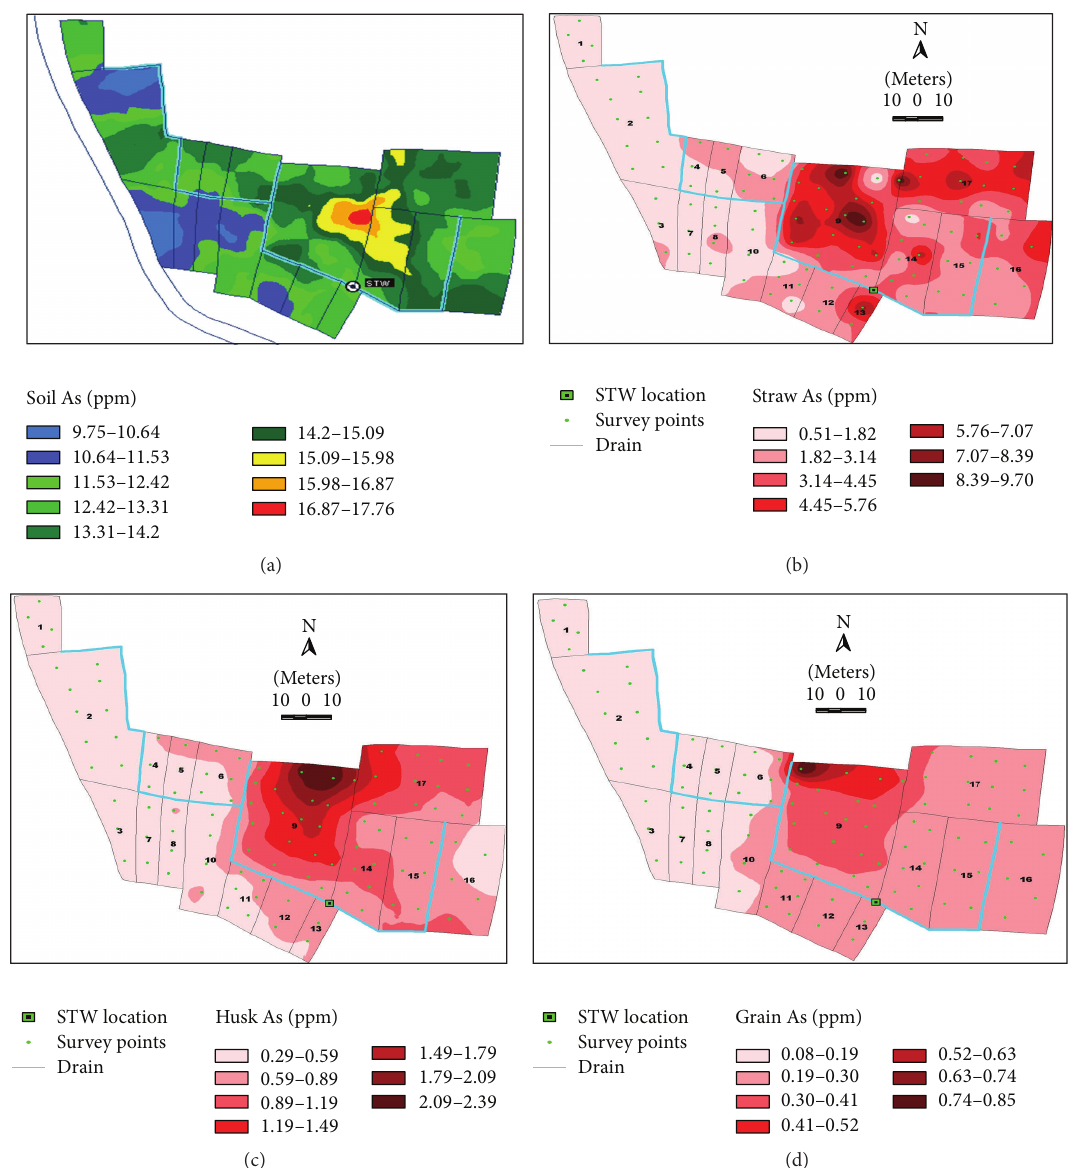
Figure 8: (a) Map of spatial variation of soil As. (b) Map of spatial variation of straw As. (c) Map of spatial variation of husk As. (d) Map of spatial variation of grain As in four command